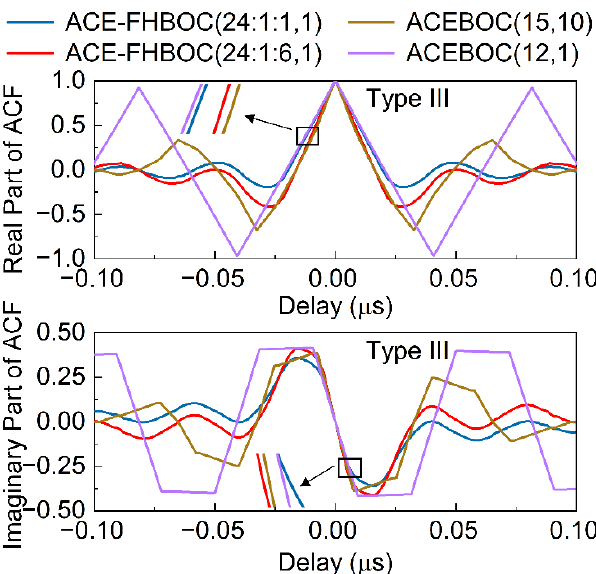
Figure 9. Normalized ACFs of the Type-III example signals.